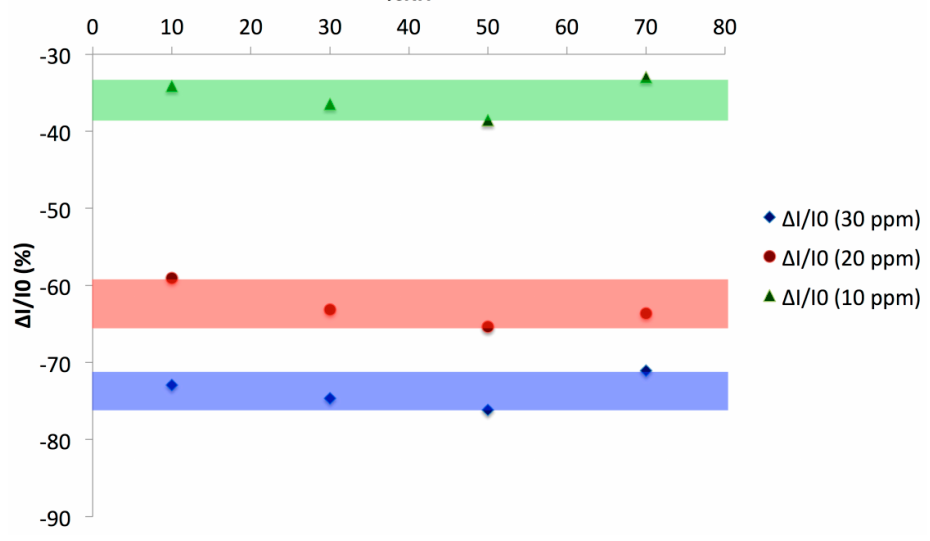
) of a (PANI/CuTsPc) device (E5) to NH as a 0 20 3 concentration is 30, 20 and 10 ppm. The green, red and 3 3